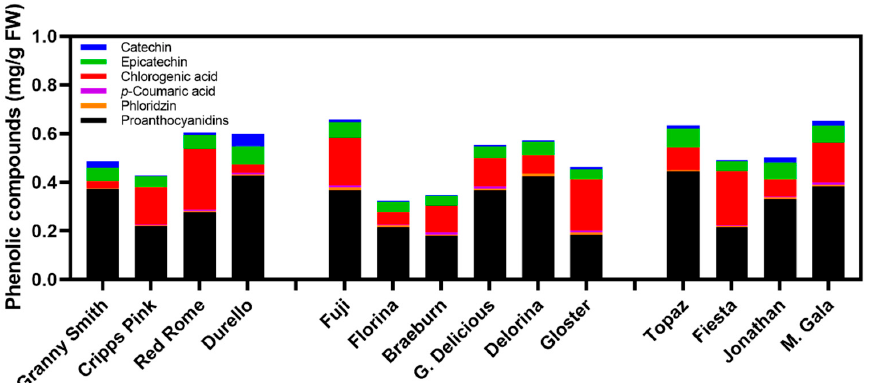
Figure 5. Composition of the phenolic compounds evaluated via high-performance liquid chro- matography (HPLC) organized by each phenolic compound class in each cultivar (averaged from all times). Cultivars are presented in the same order as in Figure 1 based on their level of flesh browning from minimal to severe. Means are displayed for each compound within each cultivar column bar. Statistics available for each compound are available in Table 2.